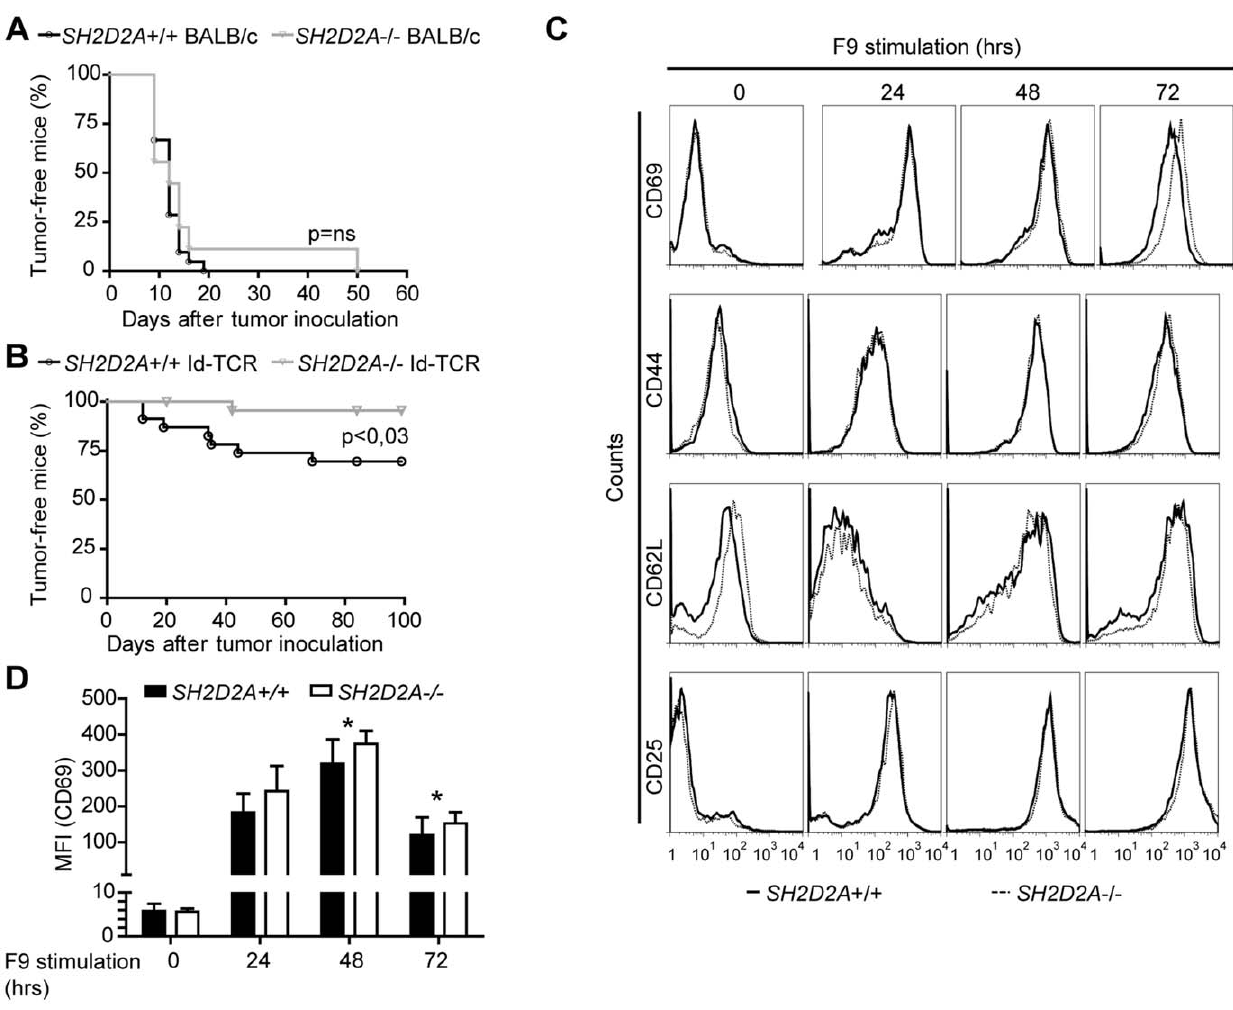
Figure 5. TCR transgenic SH2D2A 2 / 2 mice are resistant towards transplanted myeloma. Non-transgenic BALB/c and Id-specific TCR- transgenic (Id-TCR) BALB/c mice with ( + / + ) or without ( 2 / 2 ) SH2D2A expression were injected subcutaneously with low dose MOPC315 cells (160 000 cells). Tumor development was followed by palpation. (A, B) A tumor-free mouse was defined as a mouse that did not have a palpable tumor during the course of the experiment. The plots display tumor-take for (A) non-transgenic BALB/c mice with (n=9) or without (n=11) SH2D2A expression and (B) Id-specific TCR-transgenic BALB/c mice with (n=23) or without (n=23) SH2D2A expression. P values were calculated with two-tailed log rank test. Ns=non-significant.(C, D) Splenic CD4 + T cells were isolated from surviving tumor-free mice and stimulated in vitro with Id-positive F9 cells. Cells were labeled with GB113, recognizing the Id-specific transgenic TCR, and anti-CD69, CD44, CD62L or CD25 mAbs, prior to and after 24, 48 and 72 hours in culture with Id-positive cells. (C) FACS plots gated on GB113 + CD4 + T cells from one representative experiment are shown. (D) The diagram show the median value of the MFI (median fluorescent intensity) of CD69 at the indicated time points (n=11) with SD. P-values were calculated with two-tailed, unpaired student t test, * indicate significant differences (at 48 hours: p=0,003; at 72 hours: